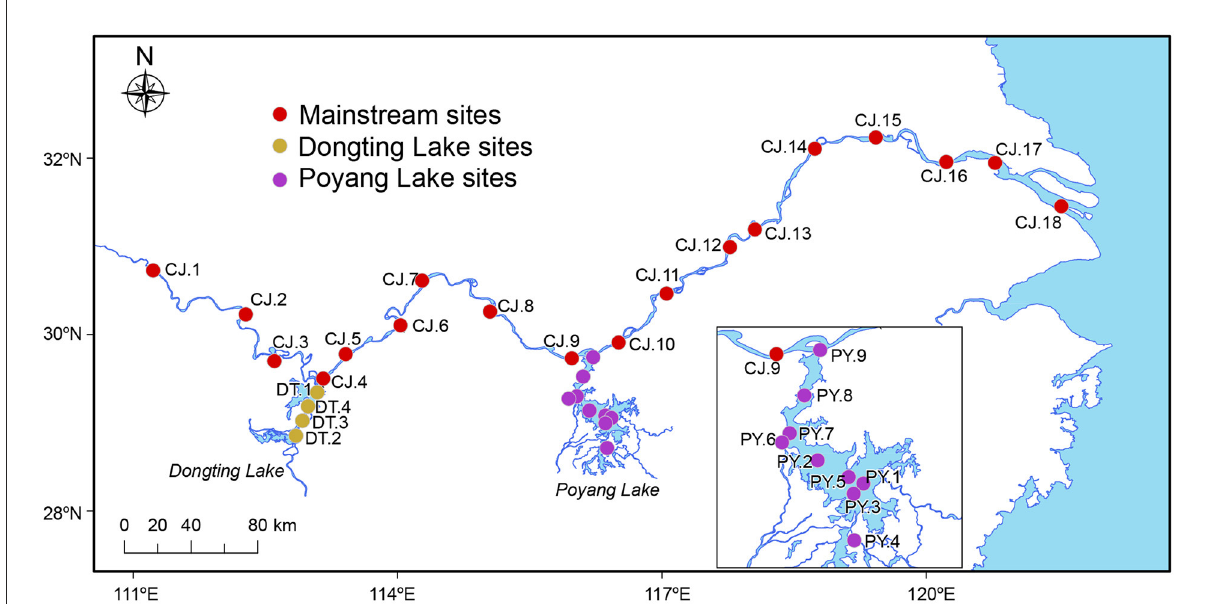
FIGURE1 Sampling sites of this study. A total of 93 samples were collected at 31 sampling sites in the Yangtze River covering the middle and lower reaches of ∼ 1,000km, as well as its two major adjoining lakes (Dongting Lake and Poyang Lake). The 18 sites in the Yangtze River mainstream were divided geographically into three sections by Dongting Lake and Poyang Lake: MS1 (four sites: CJ.1–CJ.4), MS2 (five sites: CJ.5–CJ.9) and MS3 (nine sites: CJ.10–CJ.18). The map showed drainage during the dry season when our samples were collected (Nov–Dec